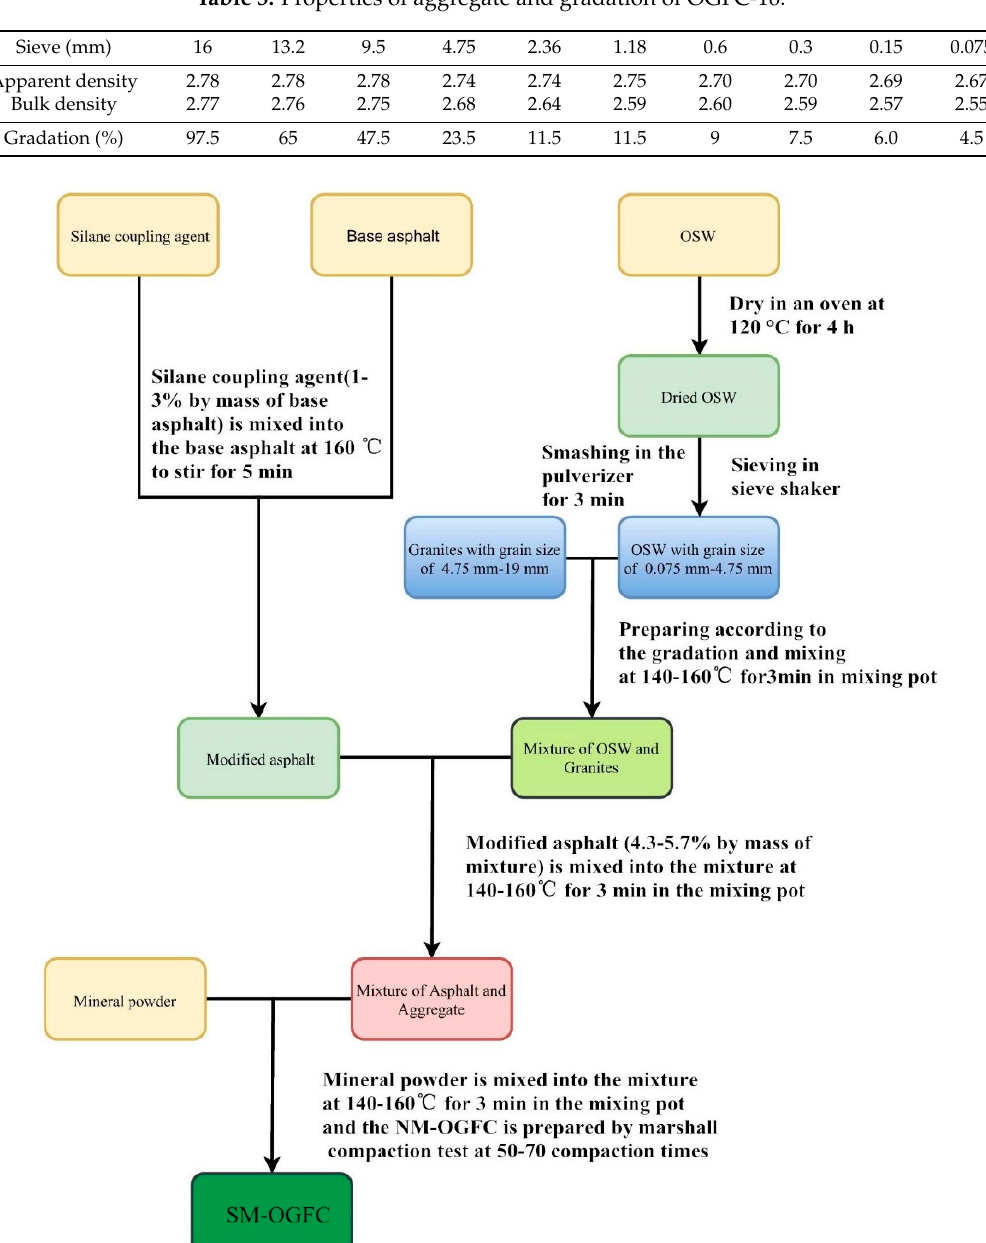
Table 3. Properties of aggregate and gradation of OGFC-16.